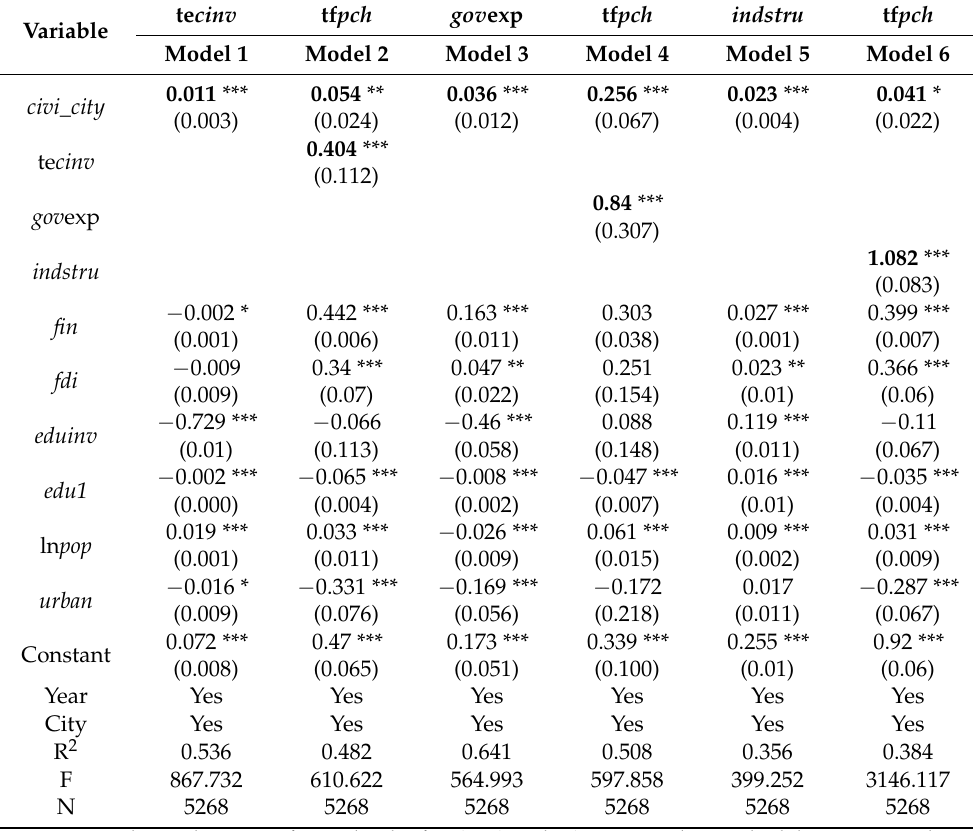
Table 6. Mechanism analysis